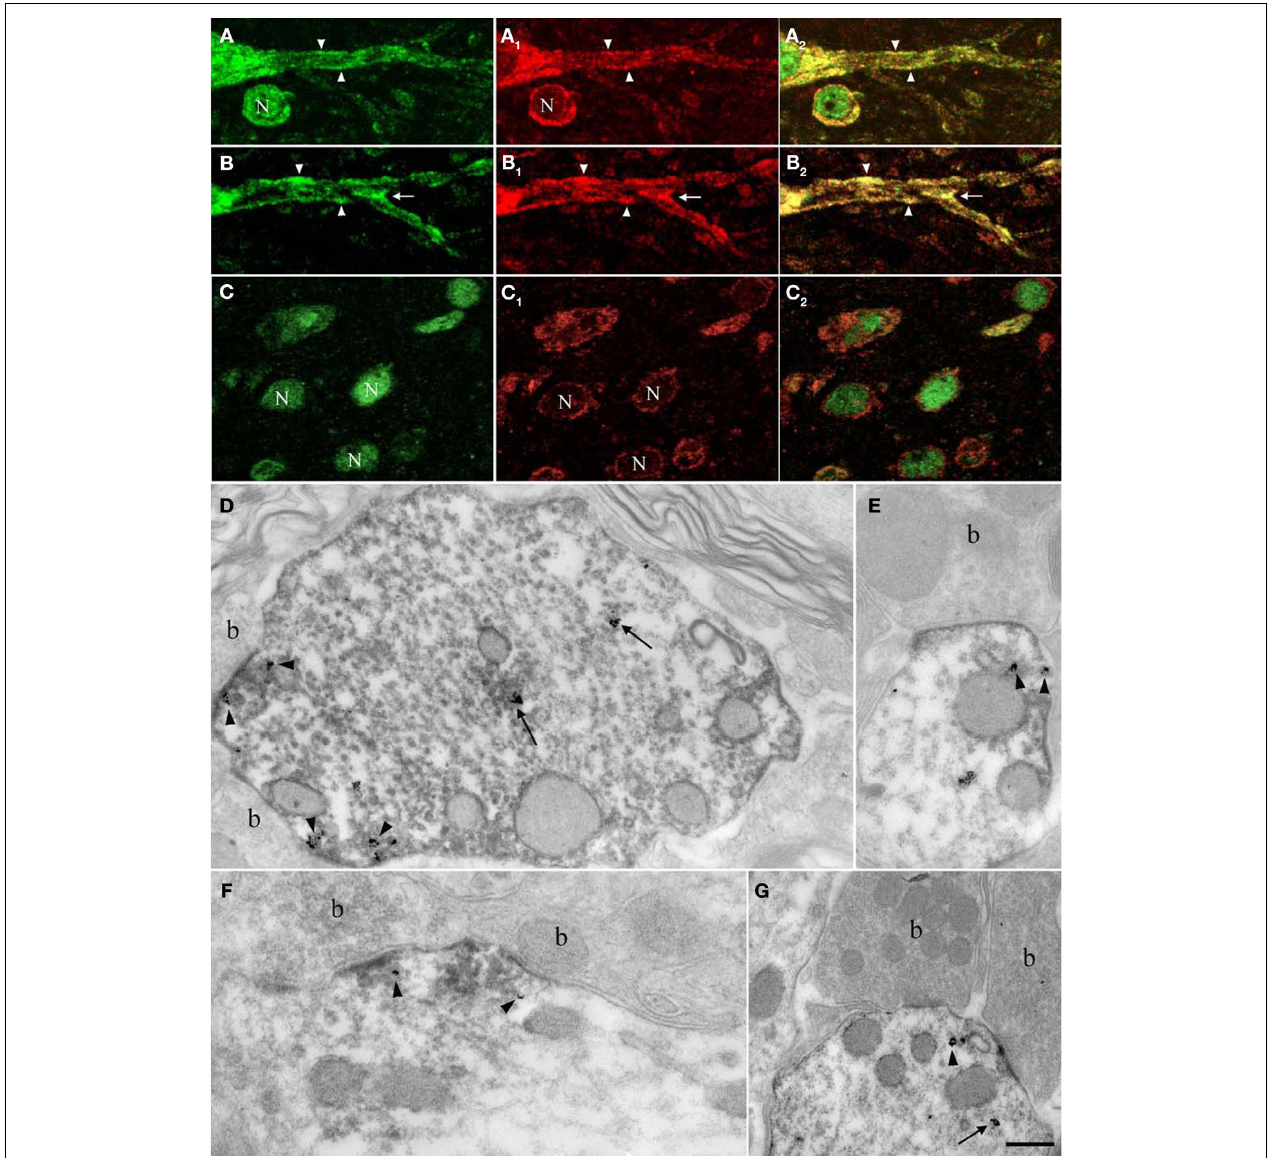
FIGURE 5 | Nova and GlyR α 2 mRNAs, its nuclear alternative splicing RNA target, colocalize outside the nucleus within dendrites. Fluorescence labeling for Nova immunoreactivity (in green; A,B,C ) and ISH signal (in red) for GlyR α 1 ( A1 ) or GlyR α 2 mRNAs ( B1,C1 ). (A) Within the somatic and dendritic cytoplasm of ventral horn neurons, GlyR α 1/2 (A1,B1) mRNAs and Nova (A,B) labeling co- localizes (in yellow; A1,B1 ). The labeling pattern of Nova mirrors that of GlyR α 1/2 mRNAs. Both are also unevenly distributed within the dendritic cytoplasm and sometimes accumulate at the dendritic periphery ( A,B ; arrowheads) and branch points ( B ; arrows). Note that the signal corresponding to Nova protein or GlyR α 1/2